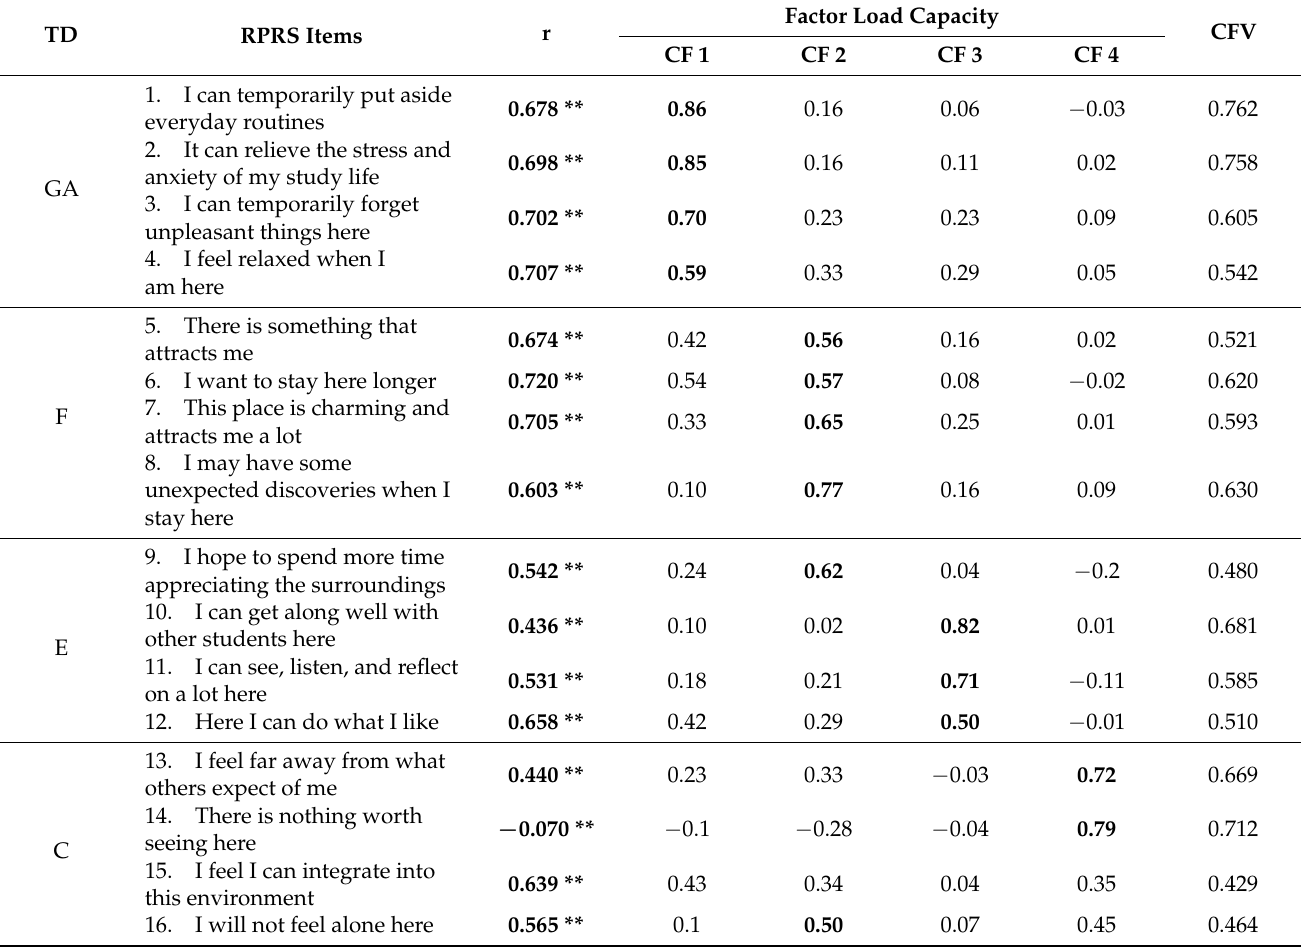
Table 1. RPRS items and factor analysis